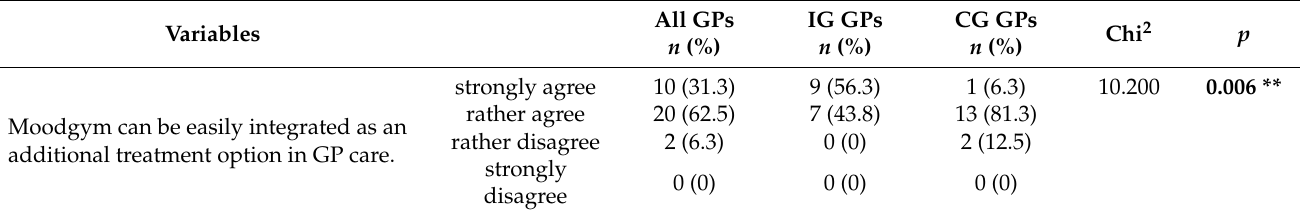
Table 2. Real-world benefit from the GP perspective